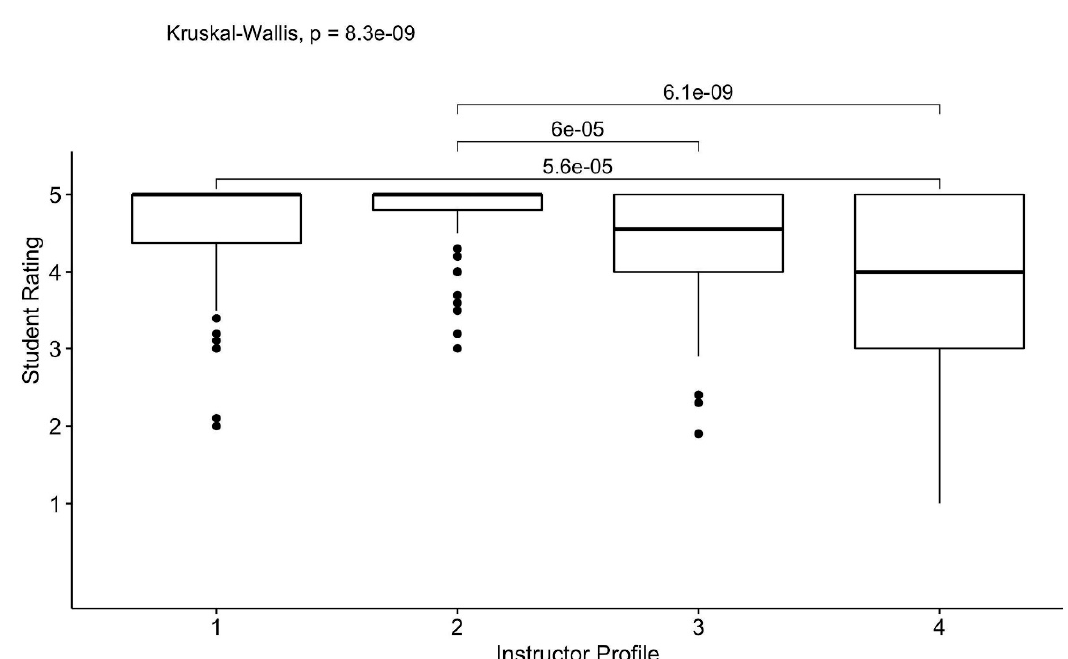
Figure 6. Ratings according to F2F Spanish course type and instructor profile. Instructor 1 is a native speaker from Spain, Instructor 2 is a native speaker from Latin America, Instructor 3 is a Heritage Speaker of Spanish, and Instructor 4 is an L2 Spanish speaker.